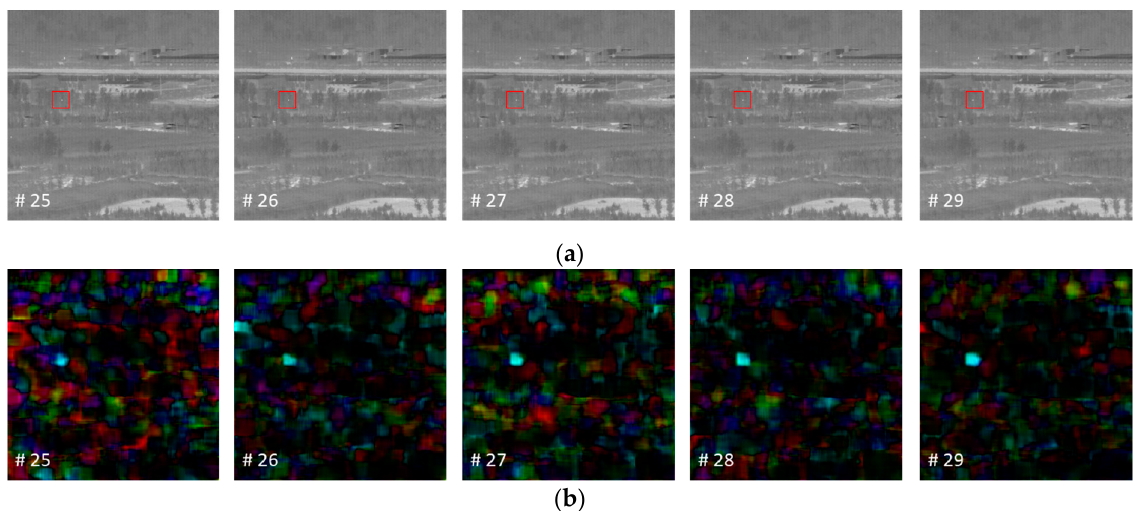
Figure 3. An infrared image sequence from the same video. The target is shown with a red rectangle. ( a ) The original infrared image sequence; ( b ) optical flow estimation of the sequence. Pixel movement is rendered with colored blocks.